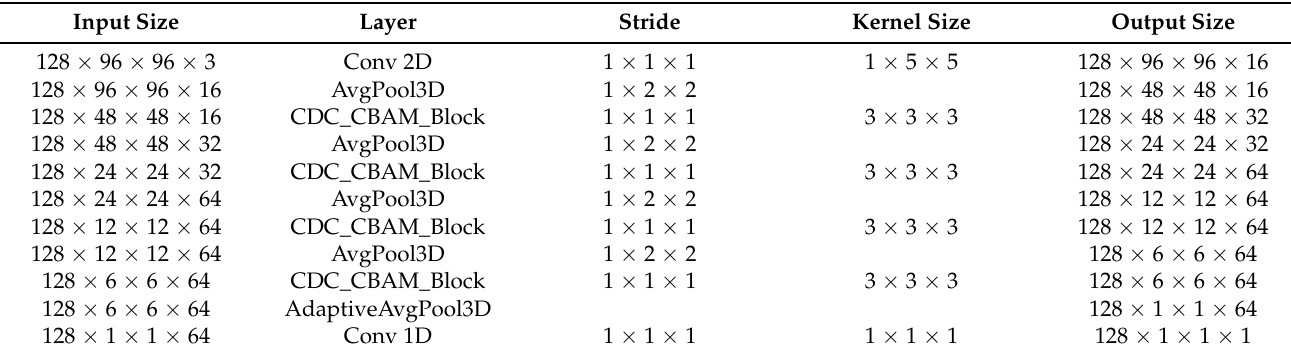
Figure 6. The overview of CDCA-rPPGNet. Table 1. The detailed structure of